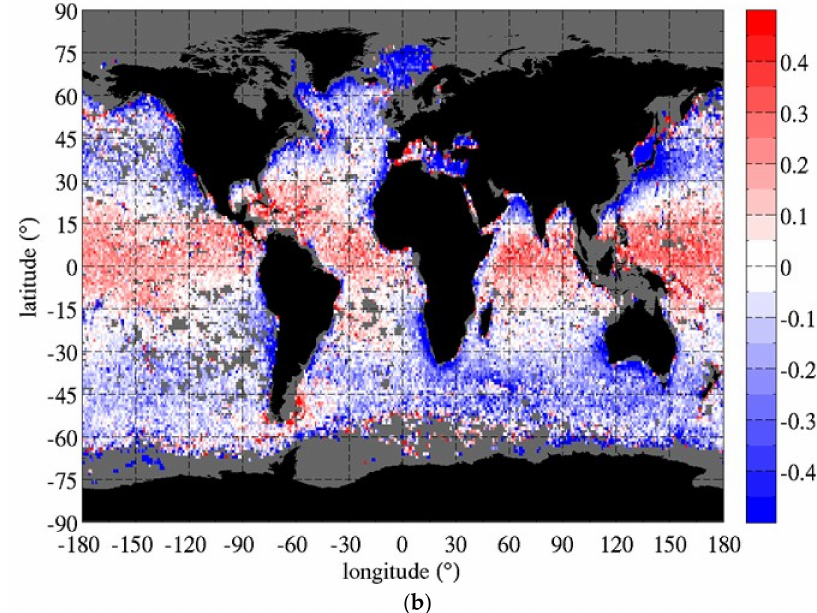
Figure 12. Salinity from the Soil Moisture Active Passive (SMAP) satellite: ( a ) global maps of SSS, remote sensing systems, Version 2, two-year average, 2015–2016; ( b ) salinity error, difference between retrieved SSS and in situ from